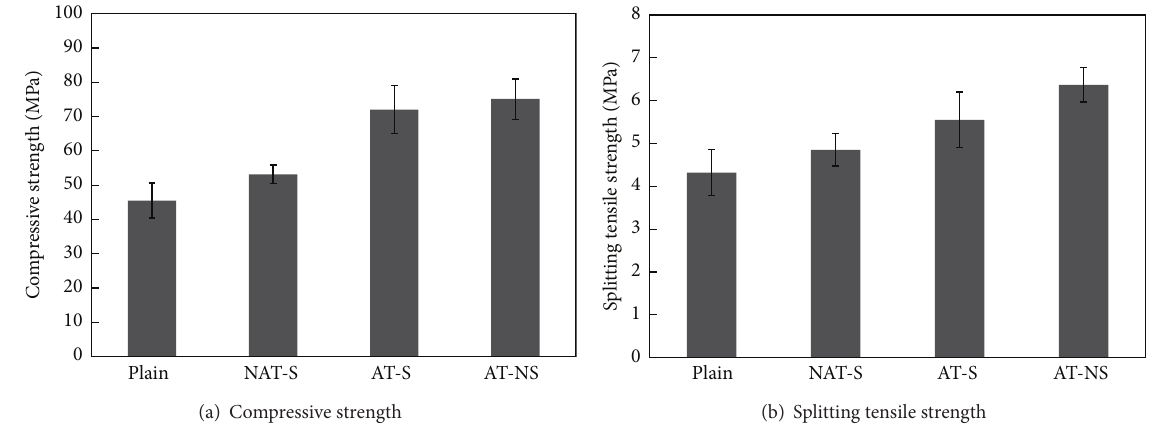
Figure 7: Comparison of strengths with different mixes.